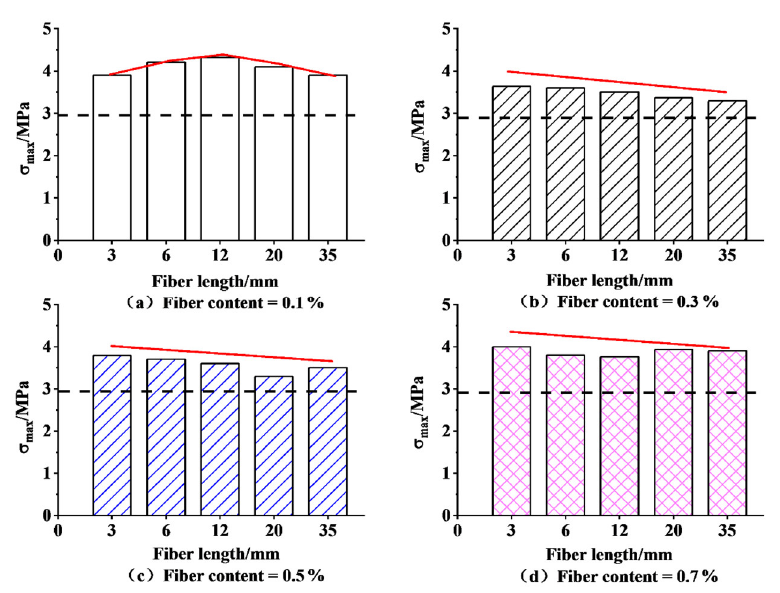
Figure 7. Variations in the peak strength with fiber length and different fiber contents.